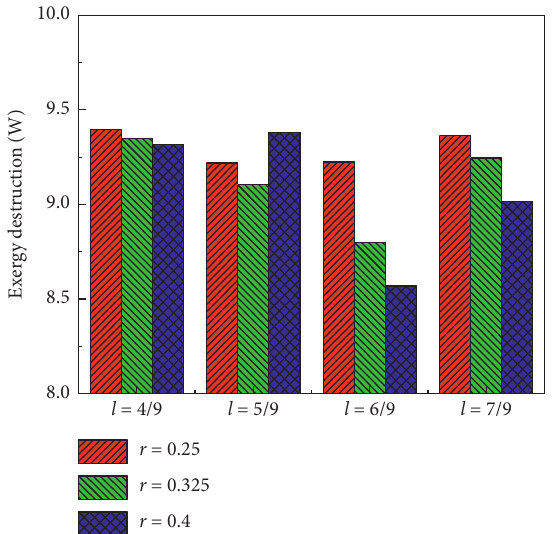
Figure 13: Exergy destruction under various l and r